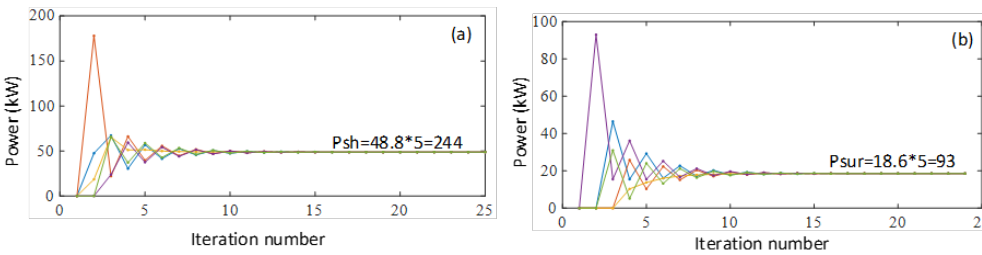
Figure 10. Information sharing (Case 2): ( a ) shortage power information; ( b ) surplus power information.